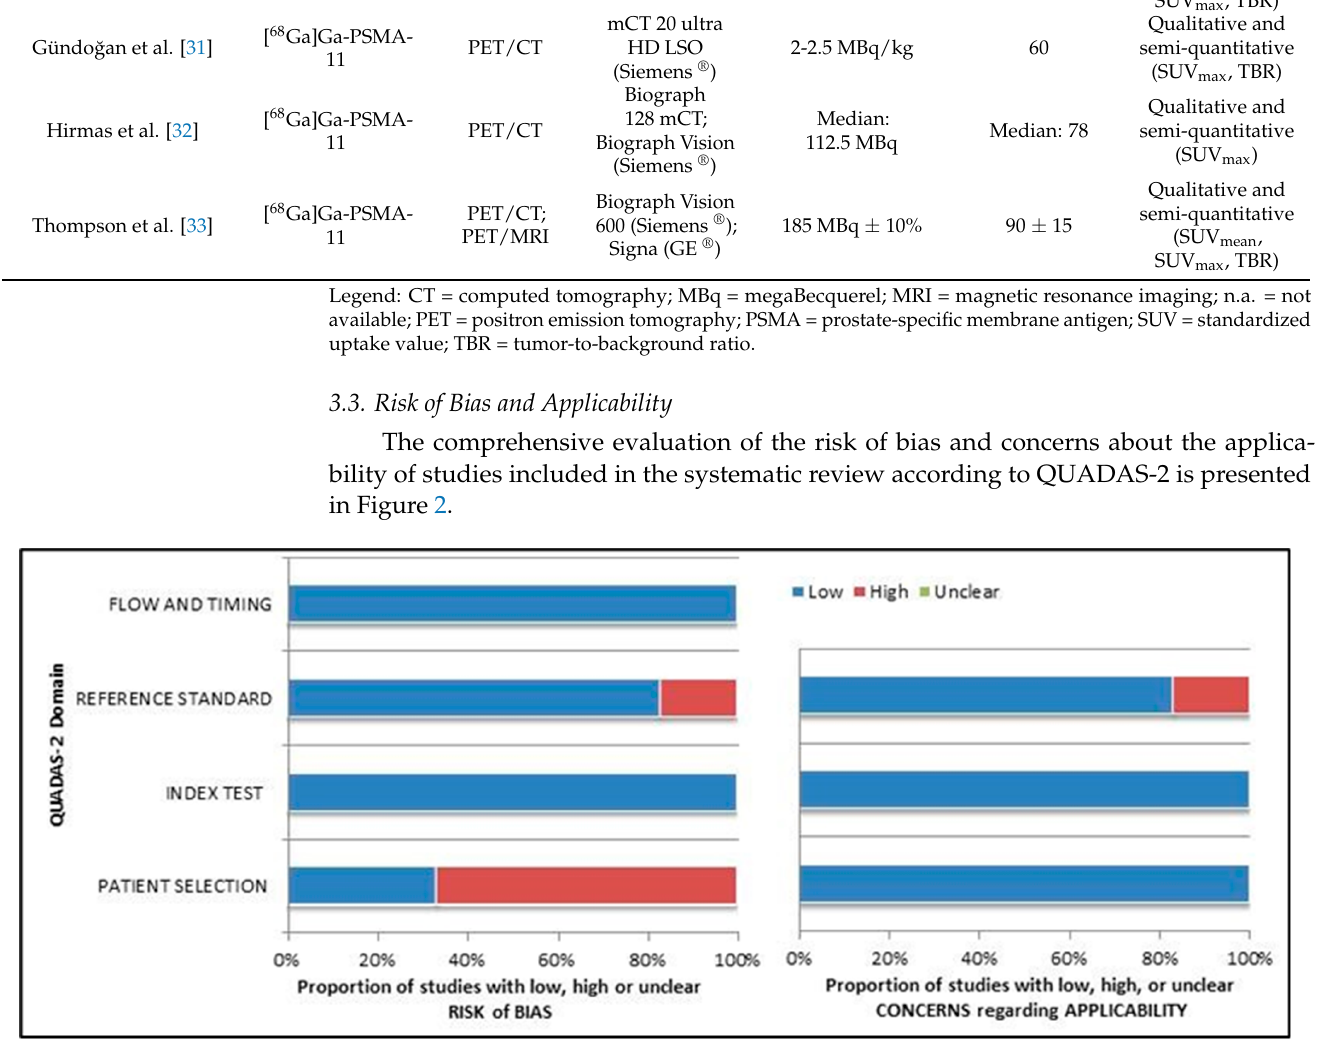
Figure 2. Summary of quality assessment according to QUADAS-2 tool. Studies included in the systematic review are classified as low risk or high risk of bias or applicability concerns for different domains (reported in the vertical axis). The horizontal axis indicates the percentage of studies. The graph suggests that more than 60% of the studies show a potentially high risk of bias in patient selection.